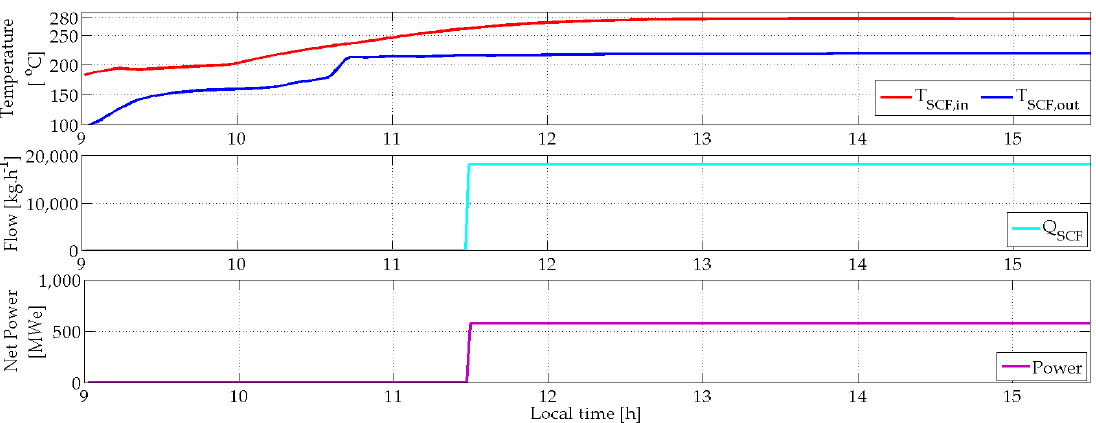
Figure 8. Evolution of the simulated oil temperatures during an experiment.